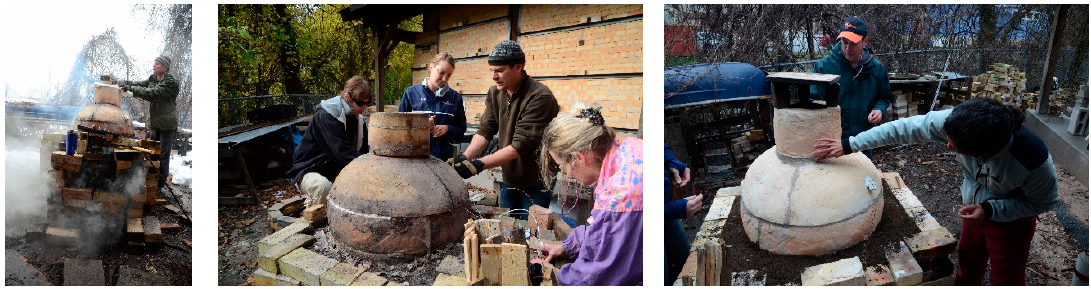
Figure 8. Touching the kiln in the warming/heating phase as it vents steam ( left ) and as fissures and cracks are patched ( center and right ).